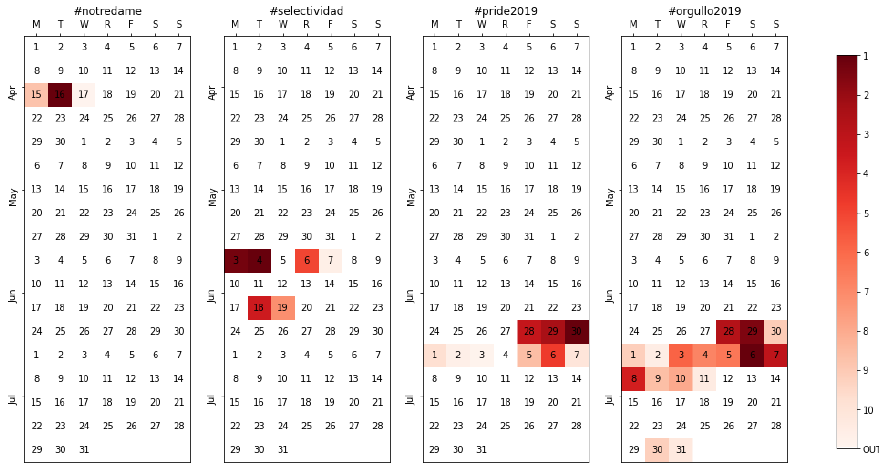
Figure 13. Calendar heatmap for a few events that happened between April and July 2019, namely #notredame, #selectividad, #pride2019, and